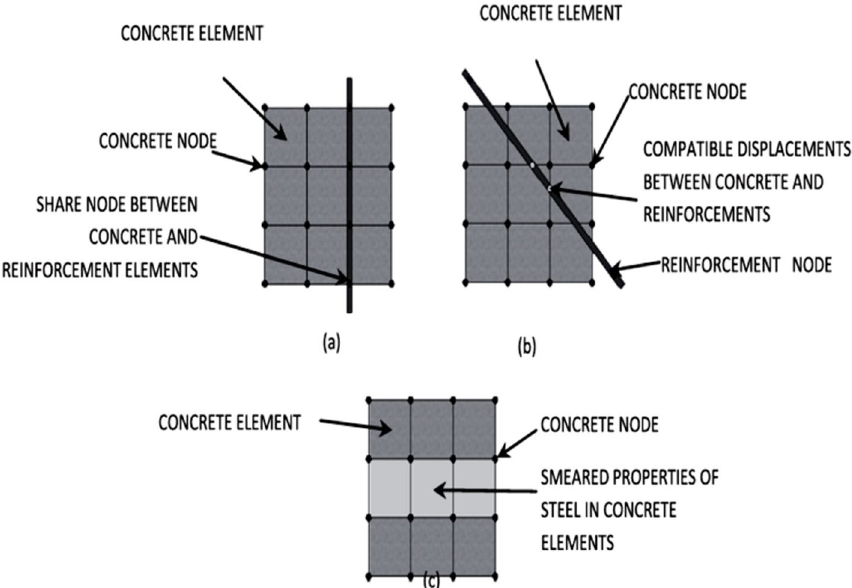
Fig. 10 Reinforced modeling techniques. a Discrete model. b Embedded model. c Smeared